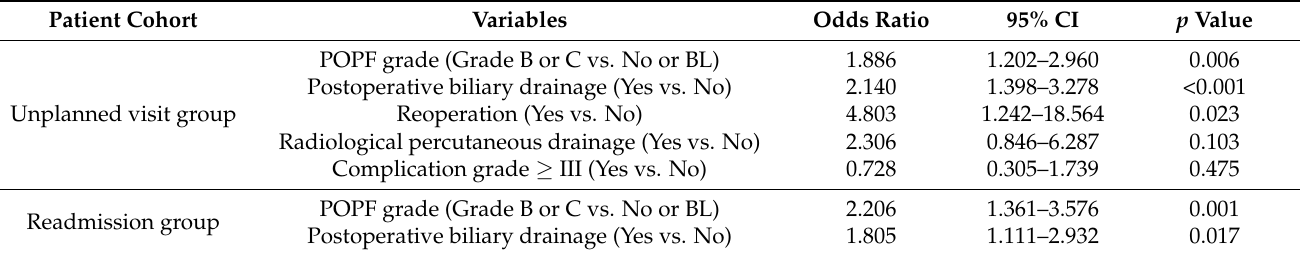
Table 4. Multivariate logistic regression analysis of factors for unplanned hospital visits or